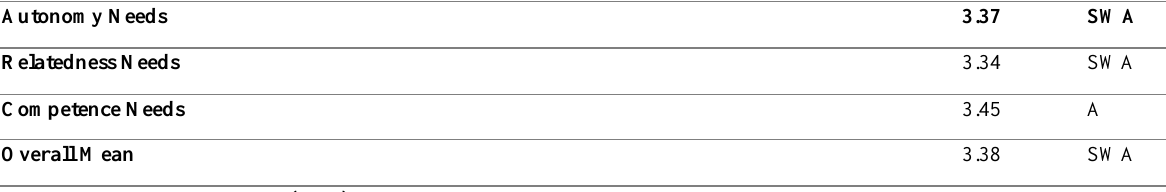
Table 5: Summary Table on Workplace Well-Being